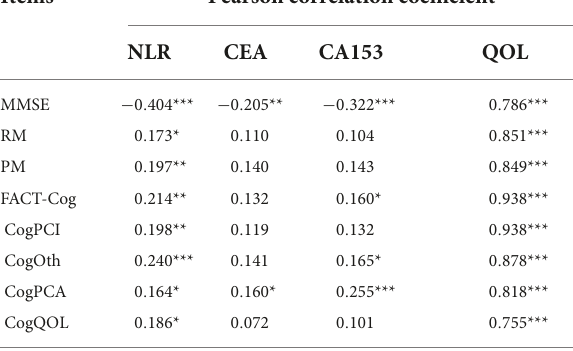
TABLE 6 Correlations of cognition with peripheral blood biomarkers levels and QOL.